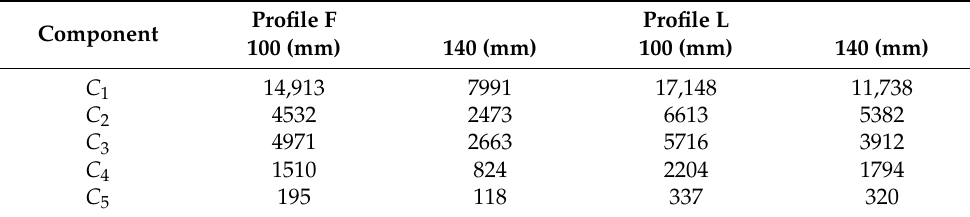
Table 6. The values of critical force F Buck (N).